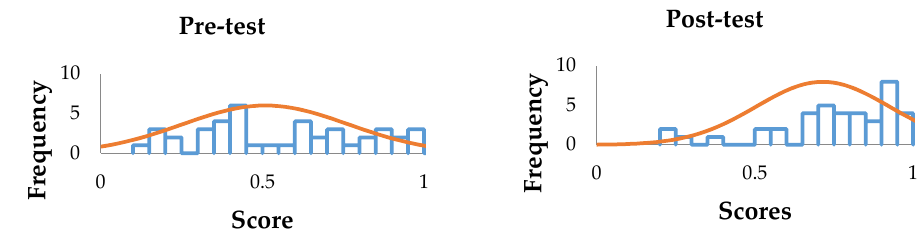
Figure 1. Pre- and post-test variability and spread.